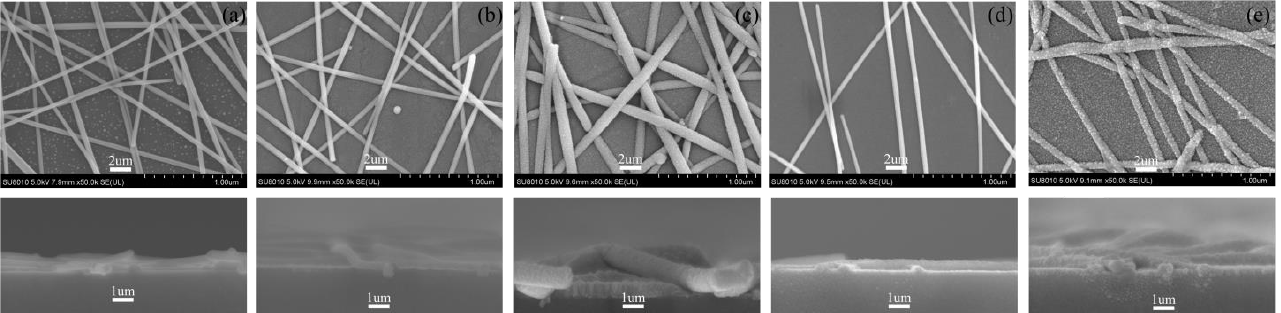
Figure 4. SEM image of the silver nanowire network of samples. ( a – e ) are the SEM images of AgNWs-TCFs, AgNWs@Al 2 O 3 -TCFs, AgNWs@SnO 2 -TCFs, AgNWs@TiO 2 -TCFs and AgNWs@ZnO-TCFs, respectively. The second row shows SEM images of cross-sections.